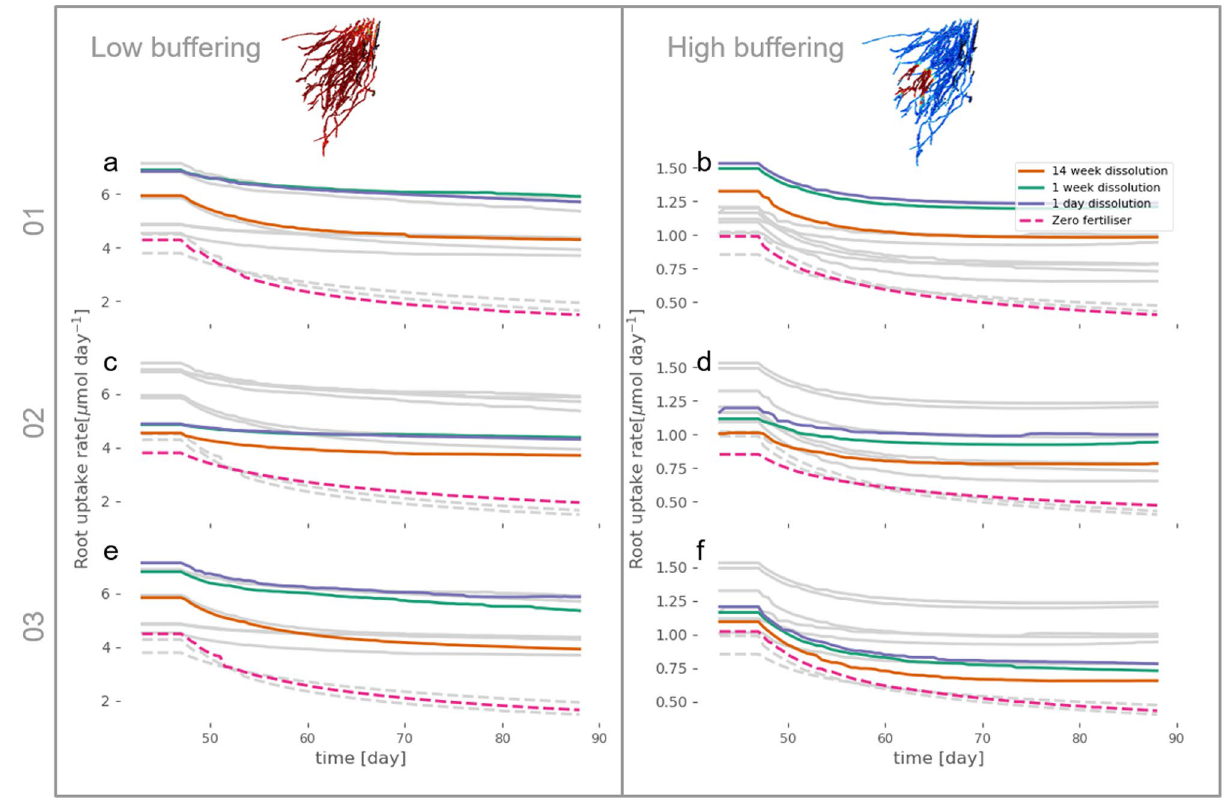
Figure 5. Simulated uptake rate dynamics from 6 weeks until 14 weeks for both the low and high buffering soil. Root uptake was started at 6 weeks following dissolution of the fertiliser from day zero. Each soil has the same total quantity of P initially. The first column shows the low buffering case (buffer power 40) and the second shows the high buffering case (buffer power 519). Each row highlights one of the three root systems showing the 4 fertiliser dissolution cases: Zero fertiliser, 14-week dissolution, 1-week dissolution and 1-day dissolution within that soil type. ( a ) Low buffering soil with 01 root system. ( b ) High buffering soil with sample 01 root system. ( c ) Low buffering soil with sample 02 root system. ( d ) High buffering soil with sample 02 root system. ( e ) Low buffering soil with sample 03 root system. ( f ) High buffering soil with sample 03 root system. For visualisation purposes, root images show uptake rate at 43 days. The faded lines show the other root system measurements in each soil type to ease comparison between